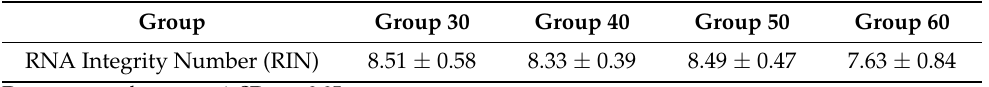
Table 2. RNA samples were used in the microarray